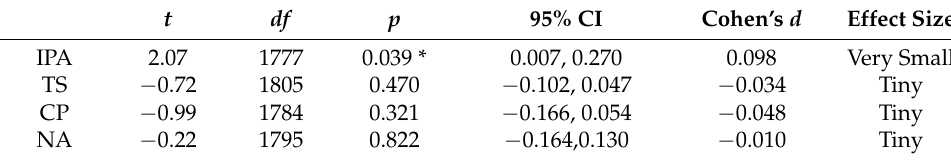
Table 5. Independent t -tests on gender.